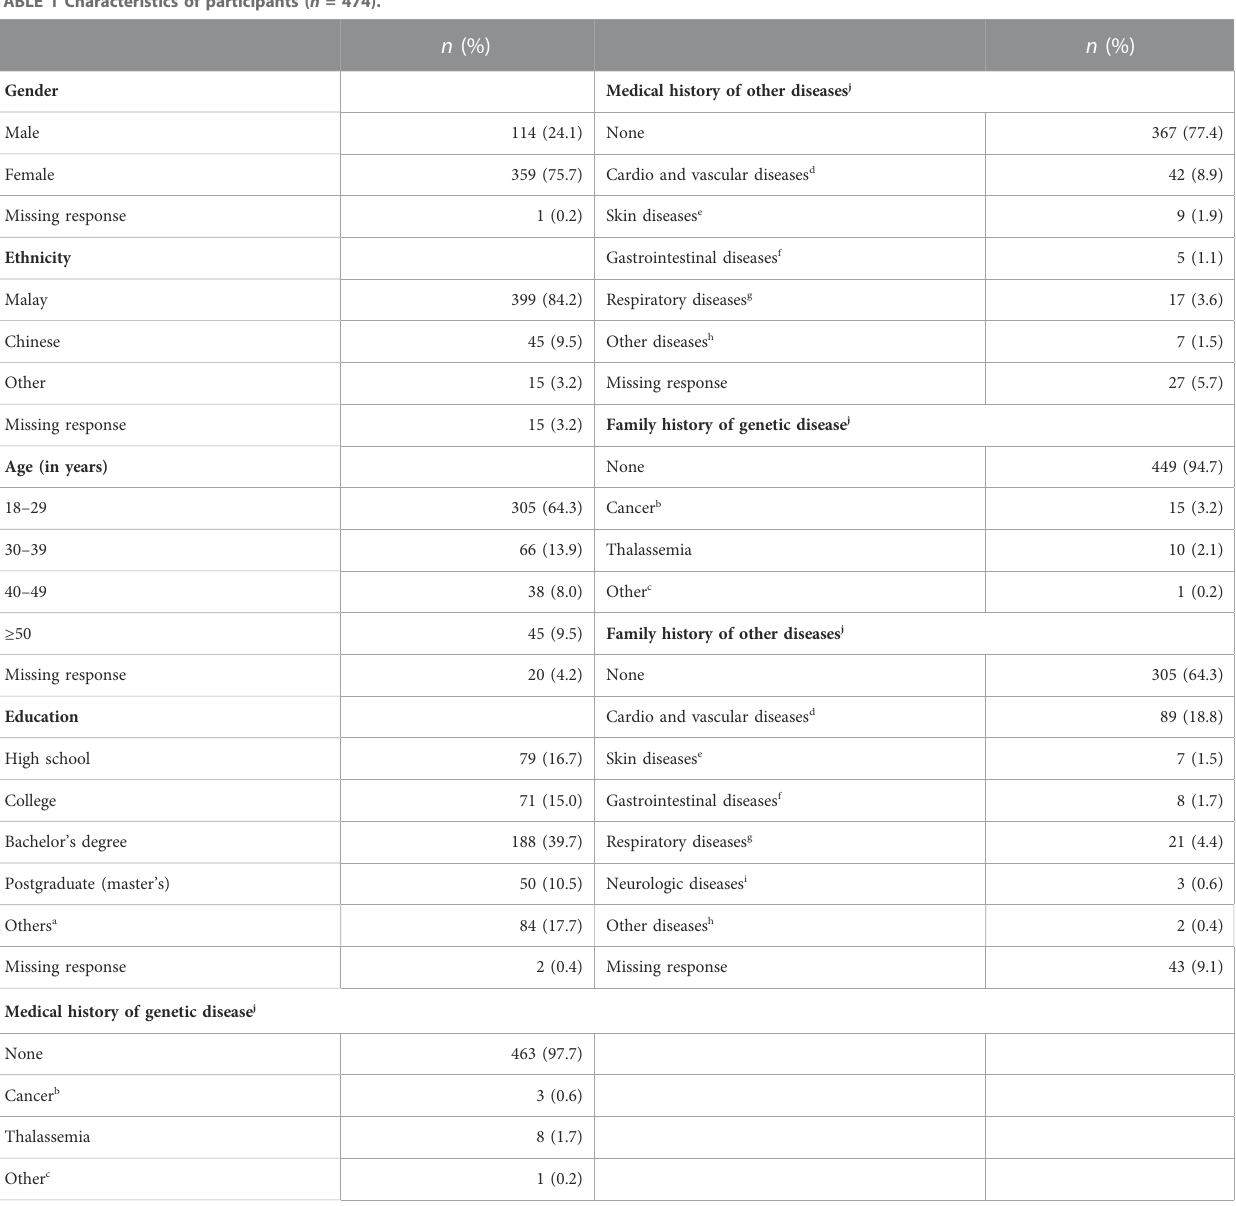
TABLE 1 Characteristics of participants ( n =